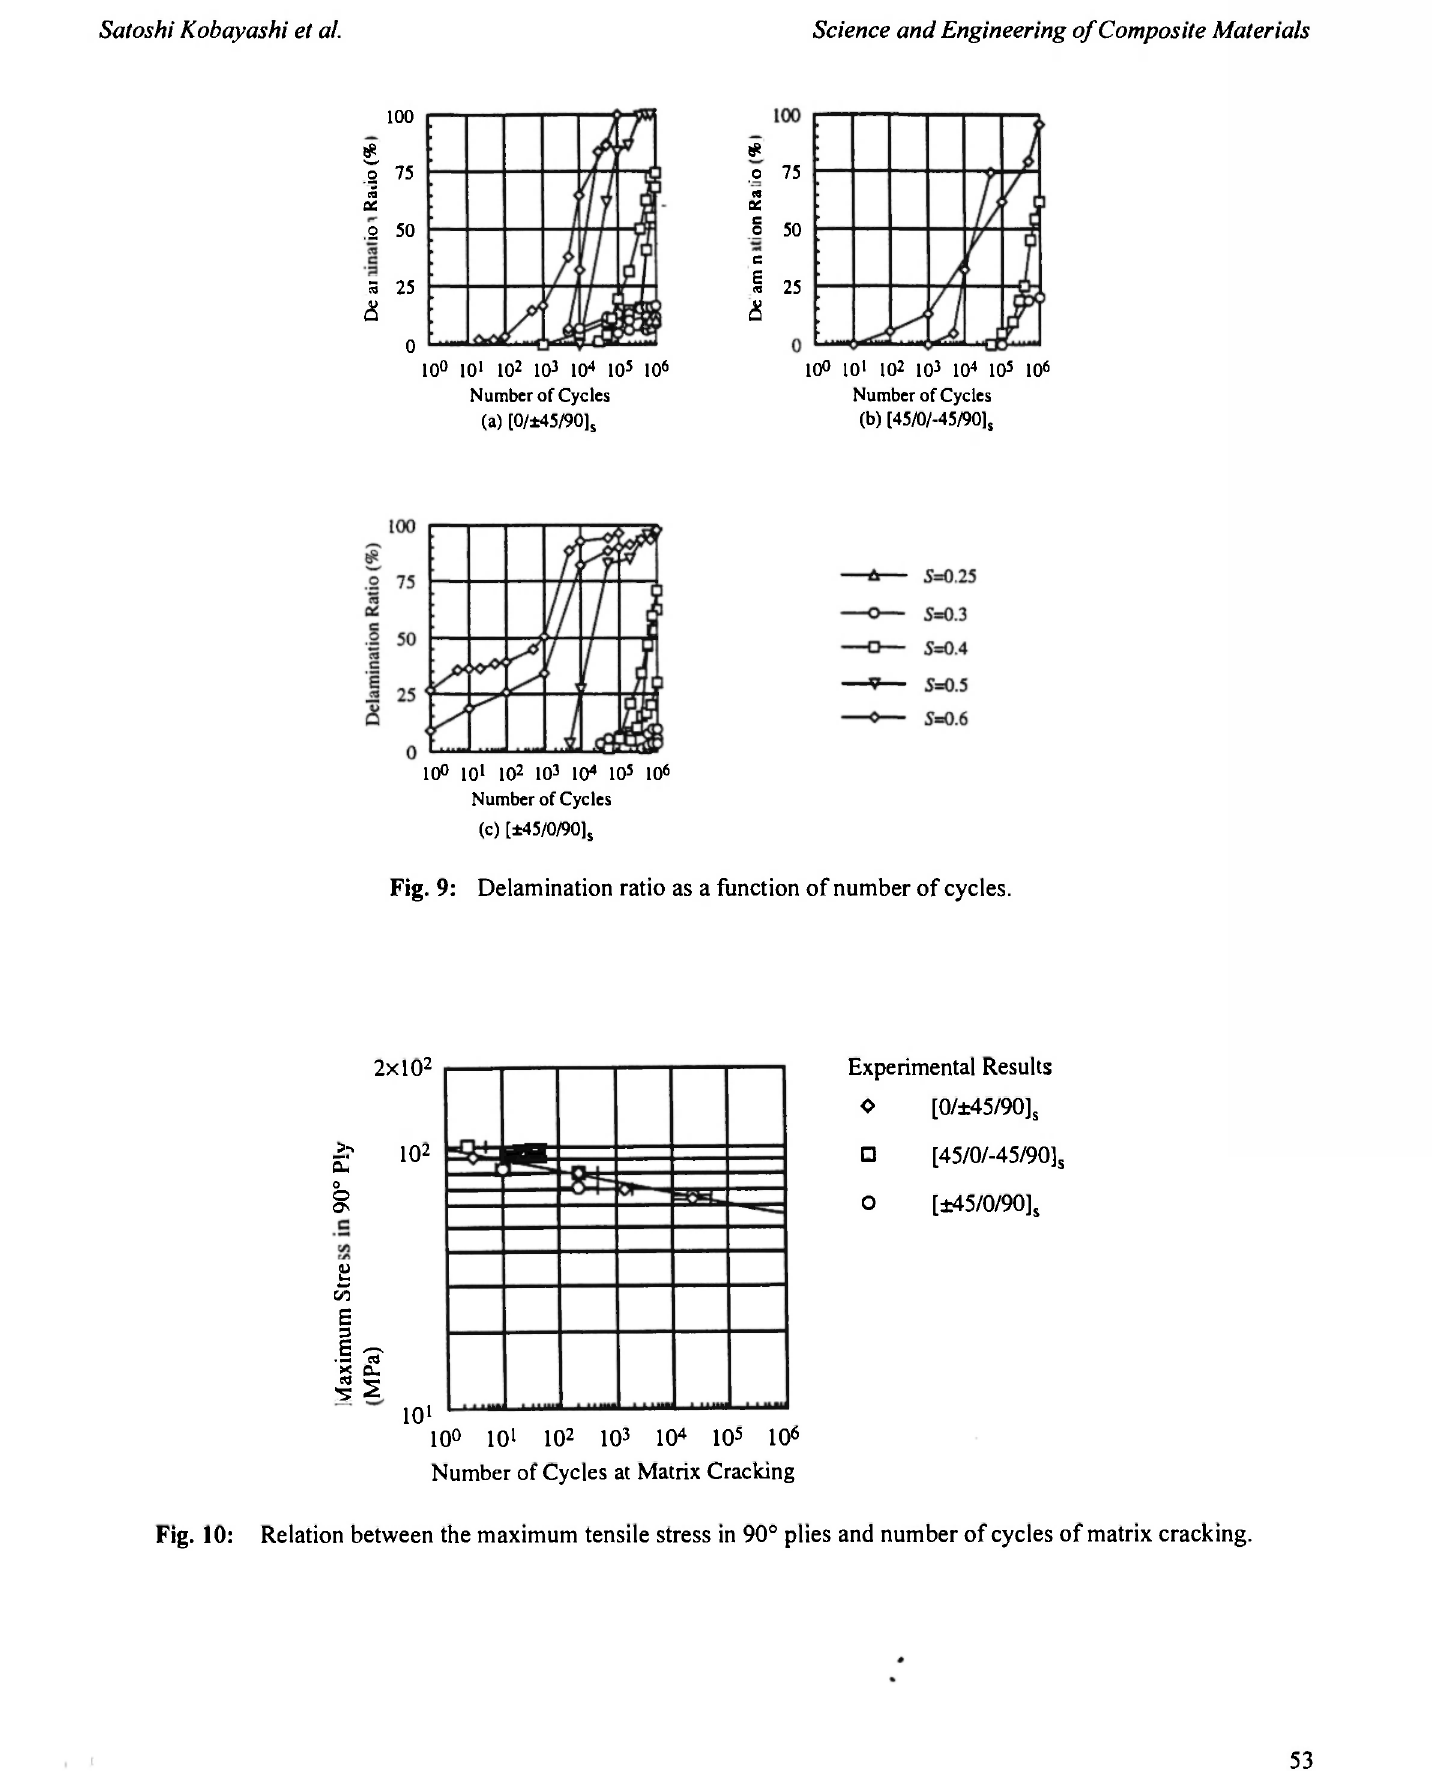
Fig. 10: Relation between the maximum tensile stress in 90° plies and number of cycles of matrix